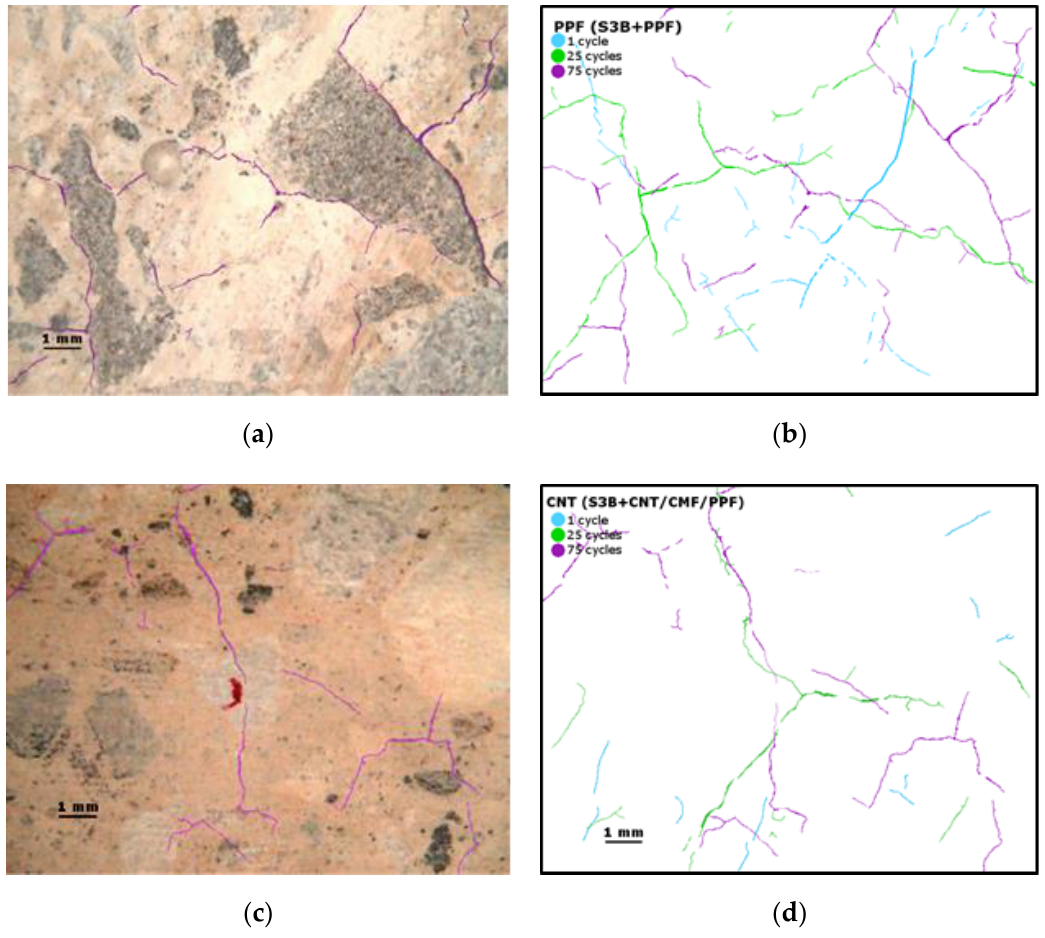
Figure 5. Crack pattern of SCC after 75 heat cycles. ( a , b ) without and ( c , d ) with 0.2%CNT + 1.4%CMF. The evolution of crack growth, identified by the maximum crack width and the percentage of the area of the concretea ff ected by the crackafter 1.25, and 75 heat / cool cycles, identified with the digital image system, is presented in Figure 6. The analysis allows the identification of a reduction in the percentage of the surface of the concrete a ff ected by the micro-cracks in the functionalized concrete with CNT + CMF compared to the reference concrete. The maximum crack width is significantly higher in the reference concrete than inthe concrete with CNT +